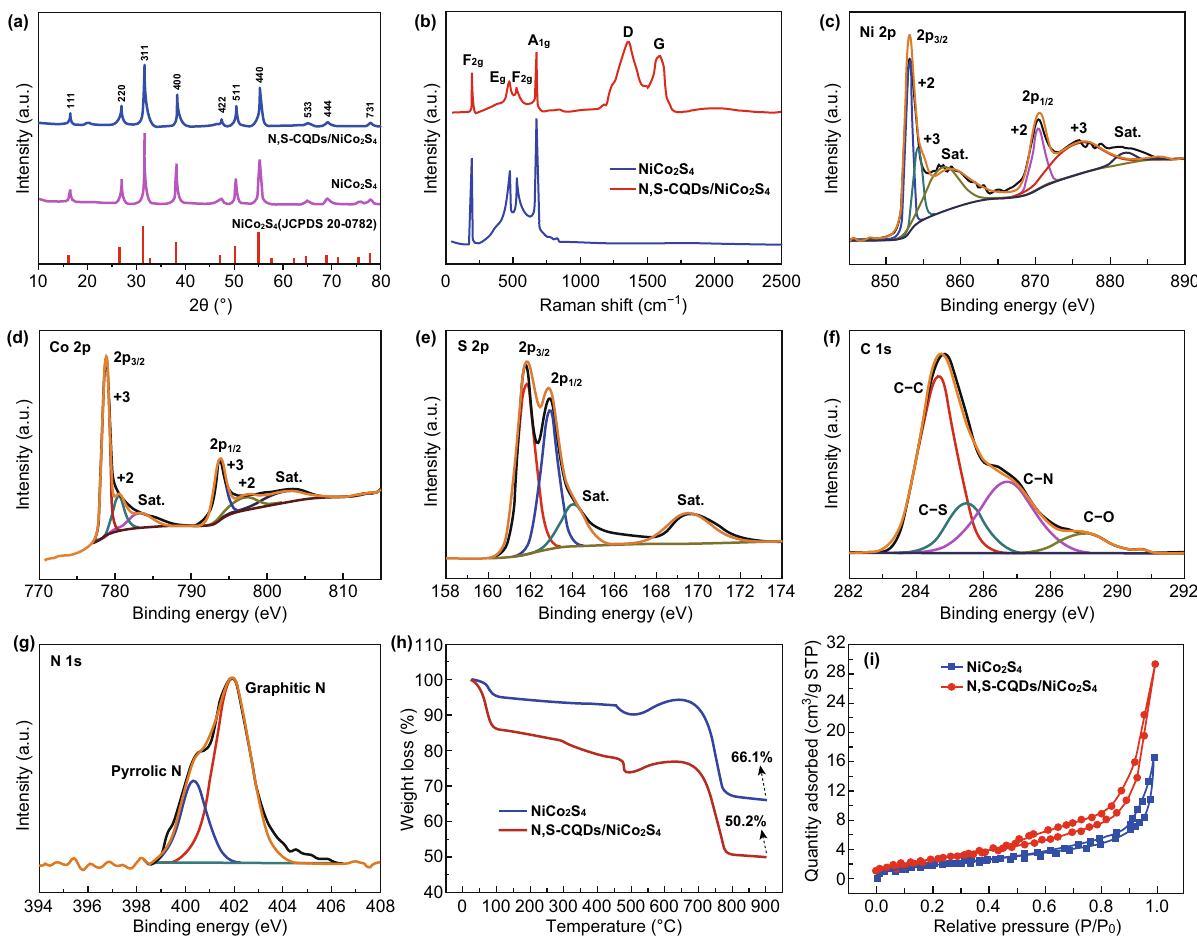
Fig. 4 a XRD patterns, b Raman spectra of the pristine NiCo 2 S 4 and N,S‑CQDs/NiCo 2 S 4 composite. XPS high‑resolution spectra of c Ni 2p, d Co 2p, e S 2p, f C 1s and g N 1s of the N,S‑CQDs/NiCo 2 S 4 composite. h TG curves and i Nitrogen adsorption–desorption isotherms of the N,S‑ CQDs/NiCo 2 S 4